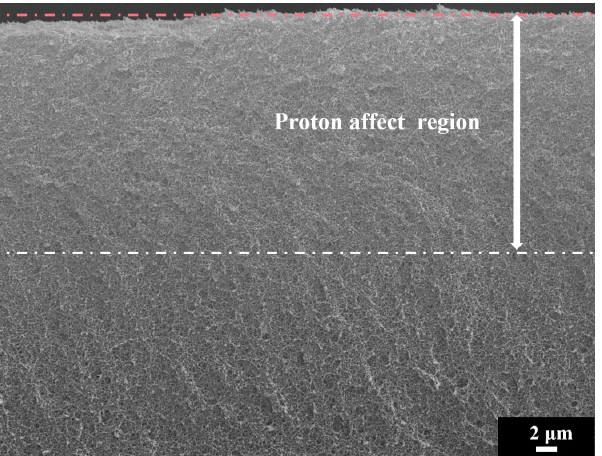
Figure 9. SEM cross-section images of polyimide aerogels after proton irradiations at fluences of 5 × 10 14 cm − 2 (the orange dashed line is the upper edge of the sample’ section, and the white dashed line is the boundary between the damaged area and damage-free area.).